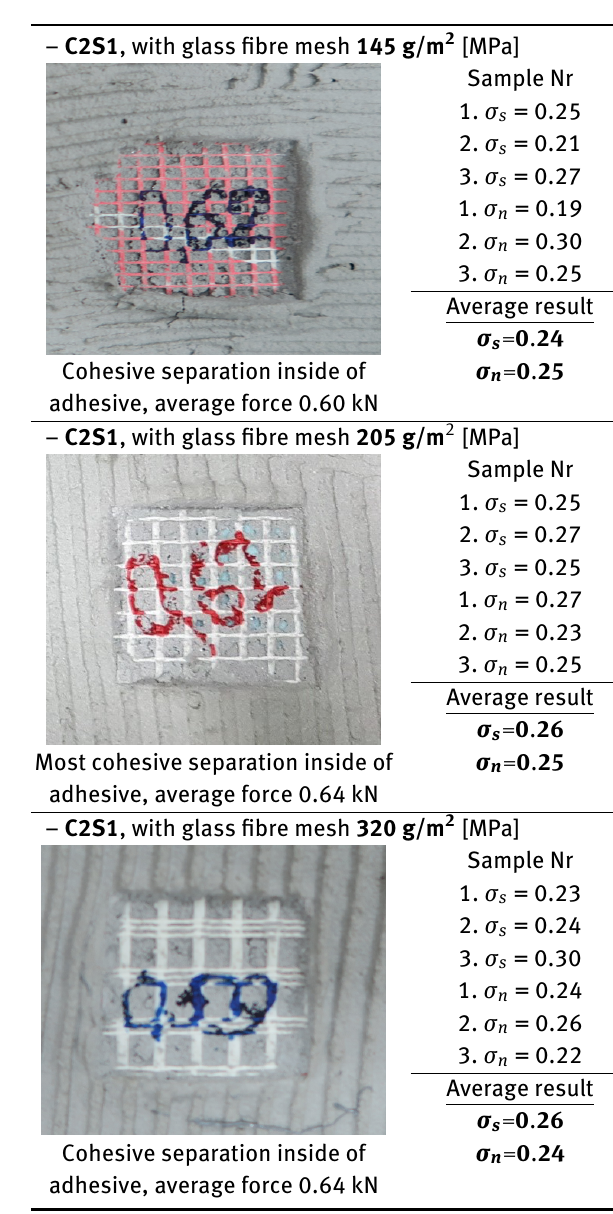
Table 1: Test results in a dry and wet condition Model A s , n (with EPS